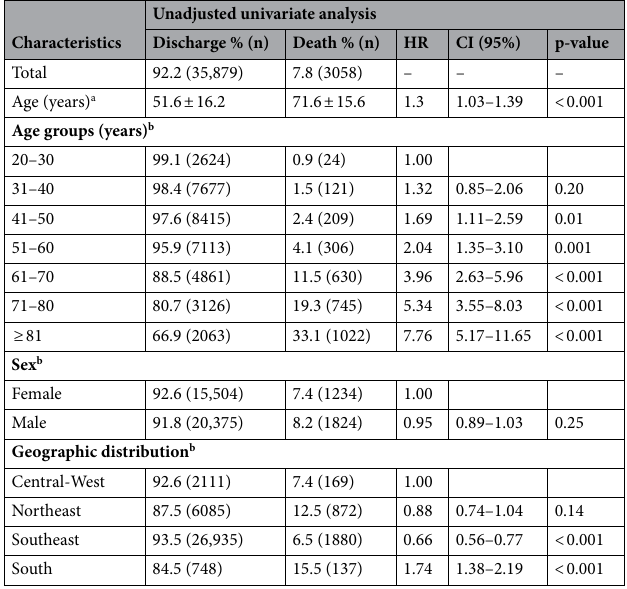
Table 1. Demographic variables of hospitalized patients with coronavirus 2019 disease (from March 1st, 2020 to March 31st, 2021). Unadjusted analysis using the Cox regression model. HR Hazard ratio, CI confidence intervals. a Values are expressed as means ± standard deviations. b Values are expressed as relative and absolute frequencies.